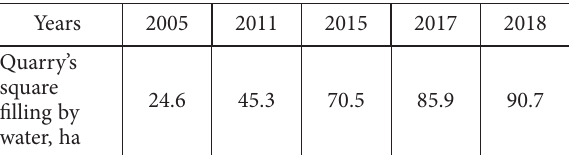
Table 3. Brines’ waterlogging dynamic of Dombrowski quarry